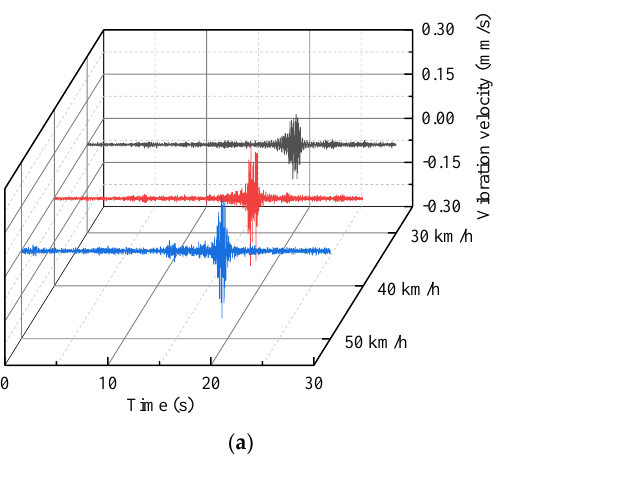
Figure 21. Predicted velocity time − history of the third floor measuring point (D − P2) under the heavy − duty truck (horizontal east − west direction): ( a ) third floor measuring point (D − P2) vibration velocity time − history prediction based on the amplitude − RTR; and ( b ) third floor measuring point (D − P2) vibration velocity time − history prediction based on the RMS − RTR. Table 3. The maximum predicted vibration velocity of the third floor measuring point (D − P2) under the action of heavy − duty trucks.